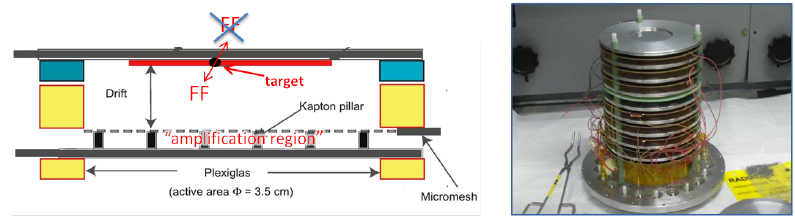
Figure 3: µ Megas detector for fission (left hand side) and stack of couples of sample / detector (right hand side).